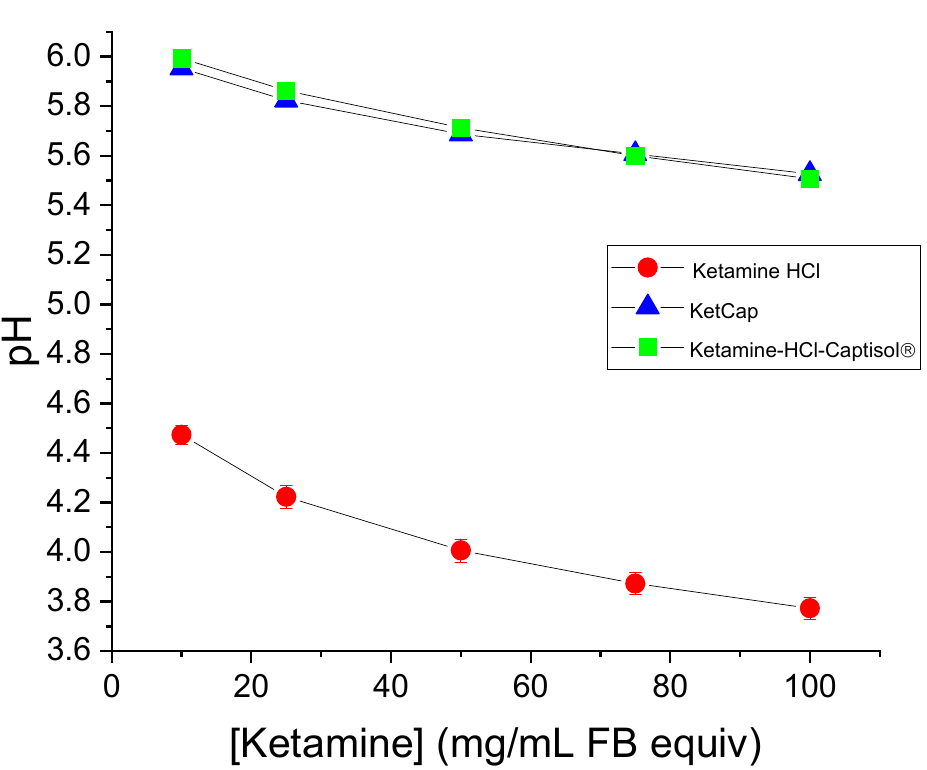
Figure 4. Relationship of ketamine concentration on pH, for Ketamine HCl, KetCap, and Ketamine- HCl-Captisol ® formulations. Data presented as mean ± SEM. N = 3.